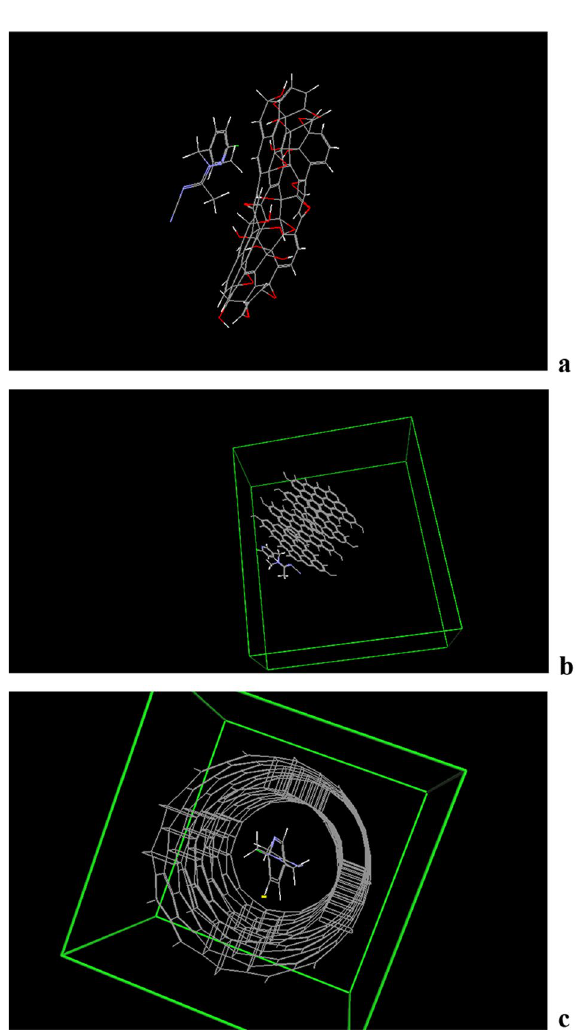
Figure 19. Graphene oxide ( a ), graphite ( b ) and multi-walled nanotubes ( c ) docking using